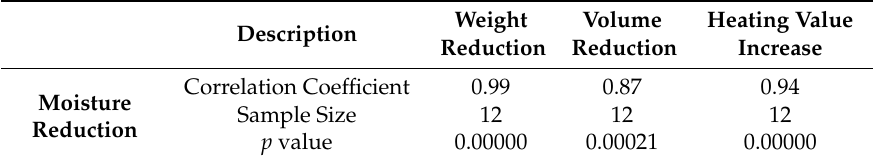
Table 3. The values of correlation, sample size, and p values of different variables related to moisture